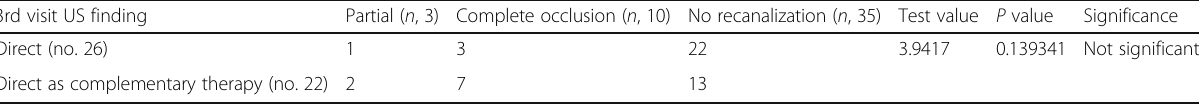
Table 12 Relation between procedure and the US follow-up findings in both 2nd and 3rd sessions 3rd visit US